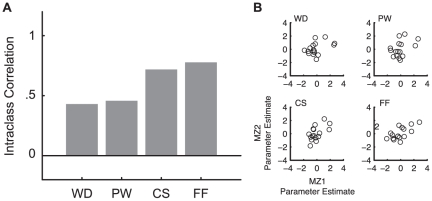

Z-transformed ICC estimates in the VWFA (A), and scatter plots of the parameter estimates between MZ twins (B).ICCFF was greater than ICCWD (p = 0.029), there was a significant linearity in the ICC across the four conditions (p = 0.010), and ICCCS and ICCFF together was greater than ICCWD and ICCPW together (p = 0.008).